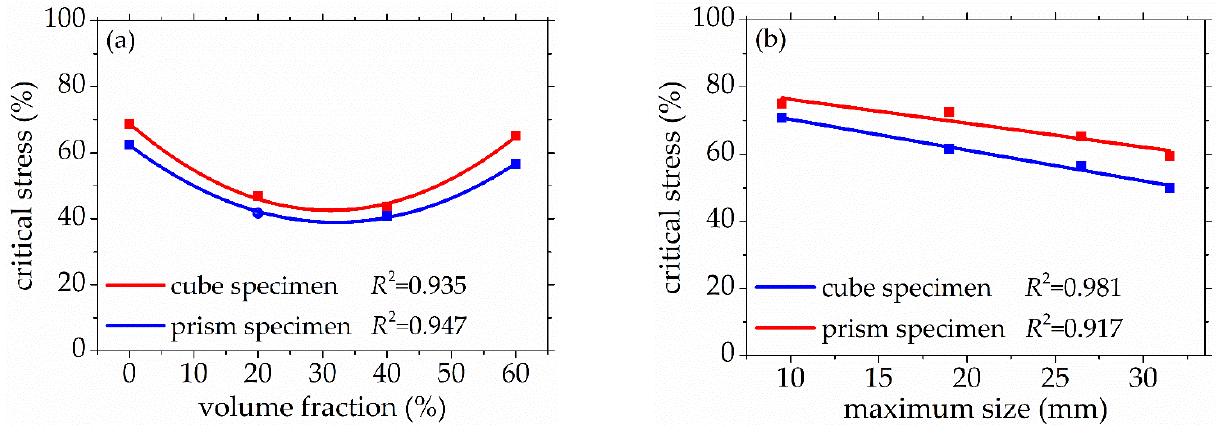
Figure 10. The relative stress ratio of concrete with different mix proportions at the turning point of damage stage I, ( a ) volume fraction, ( b ) maximum size.